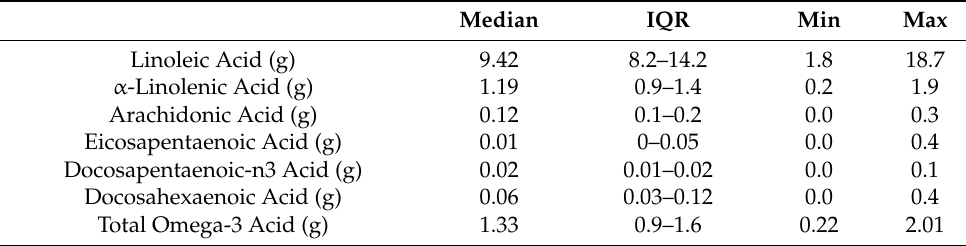
Table 5. Maternal PUFA Dietary Intake.